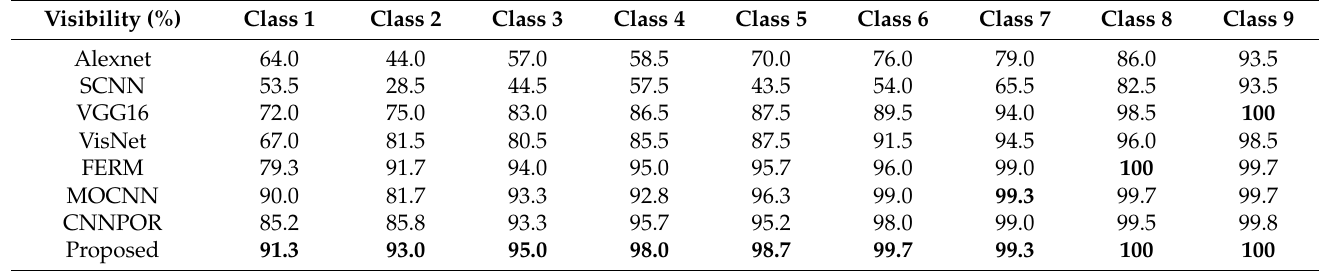
Table 6. Experimental results of different deep methods at each level with the ExFRIDA